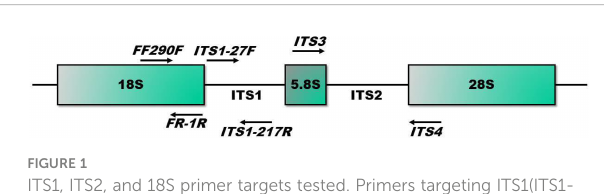
FIGURE 1 ITS1, ITS2, and 18S primer targets tested. Primers targeting ITS1(ITS1-